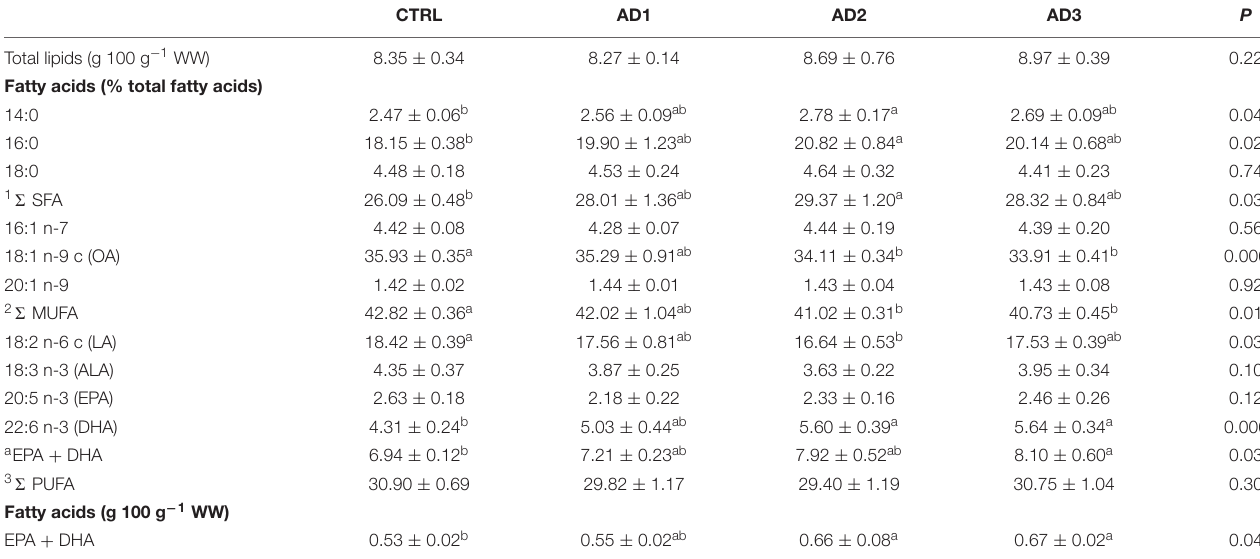
TABLE 7 | Muscle total lipid content and fatty acid composition. CTRL AD1 AD2 AD3